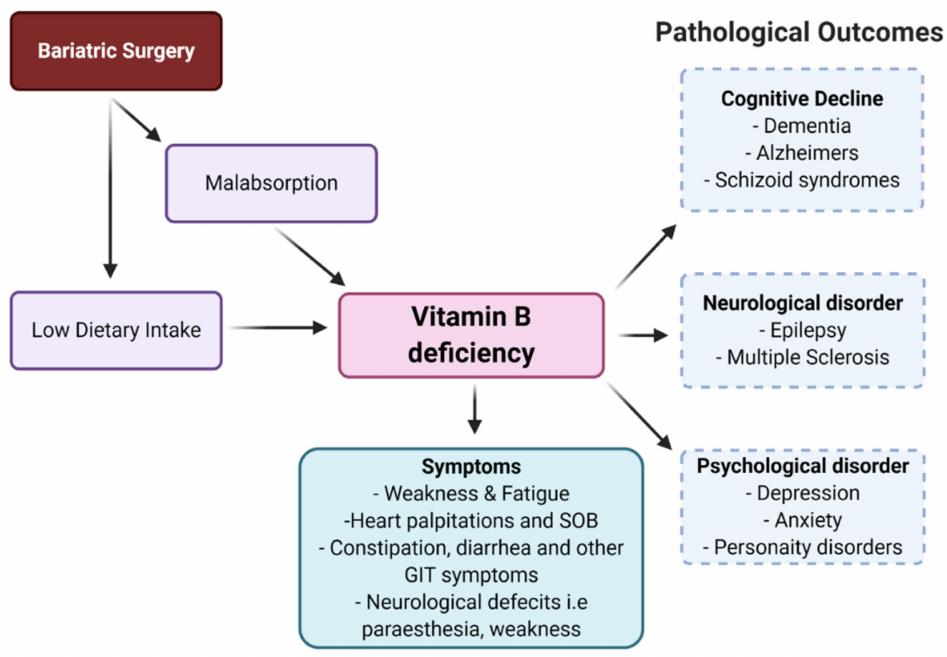
Figure 1. Symptoms and outcomes of vitamin B